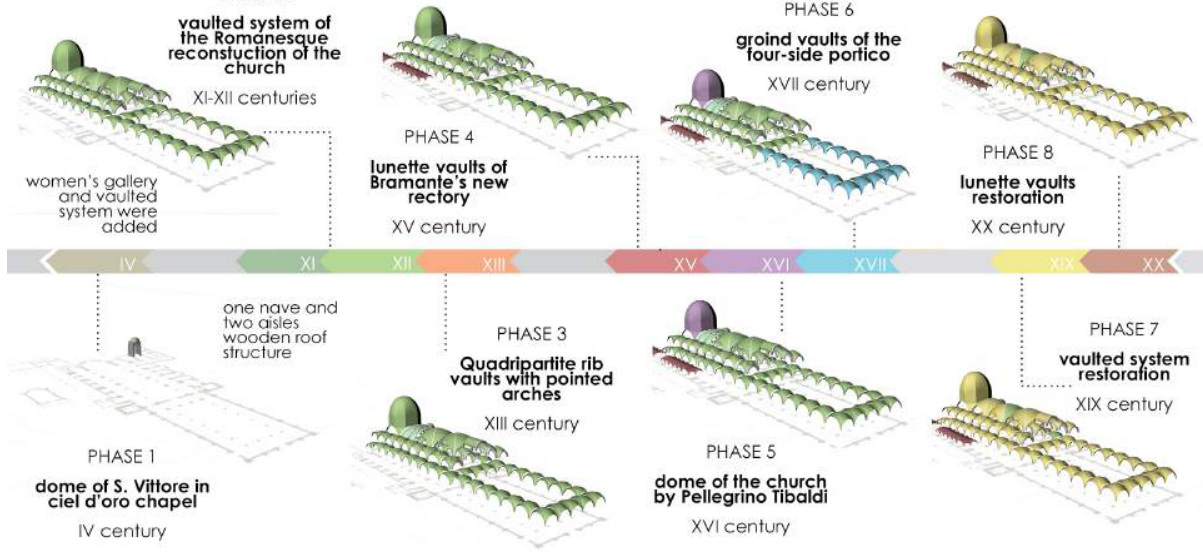
Figure 3. The vaulted system across the